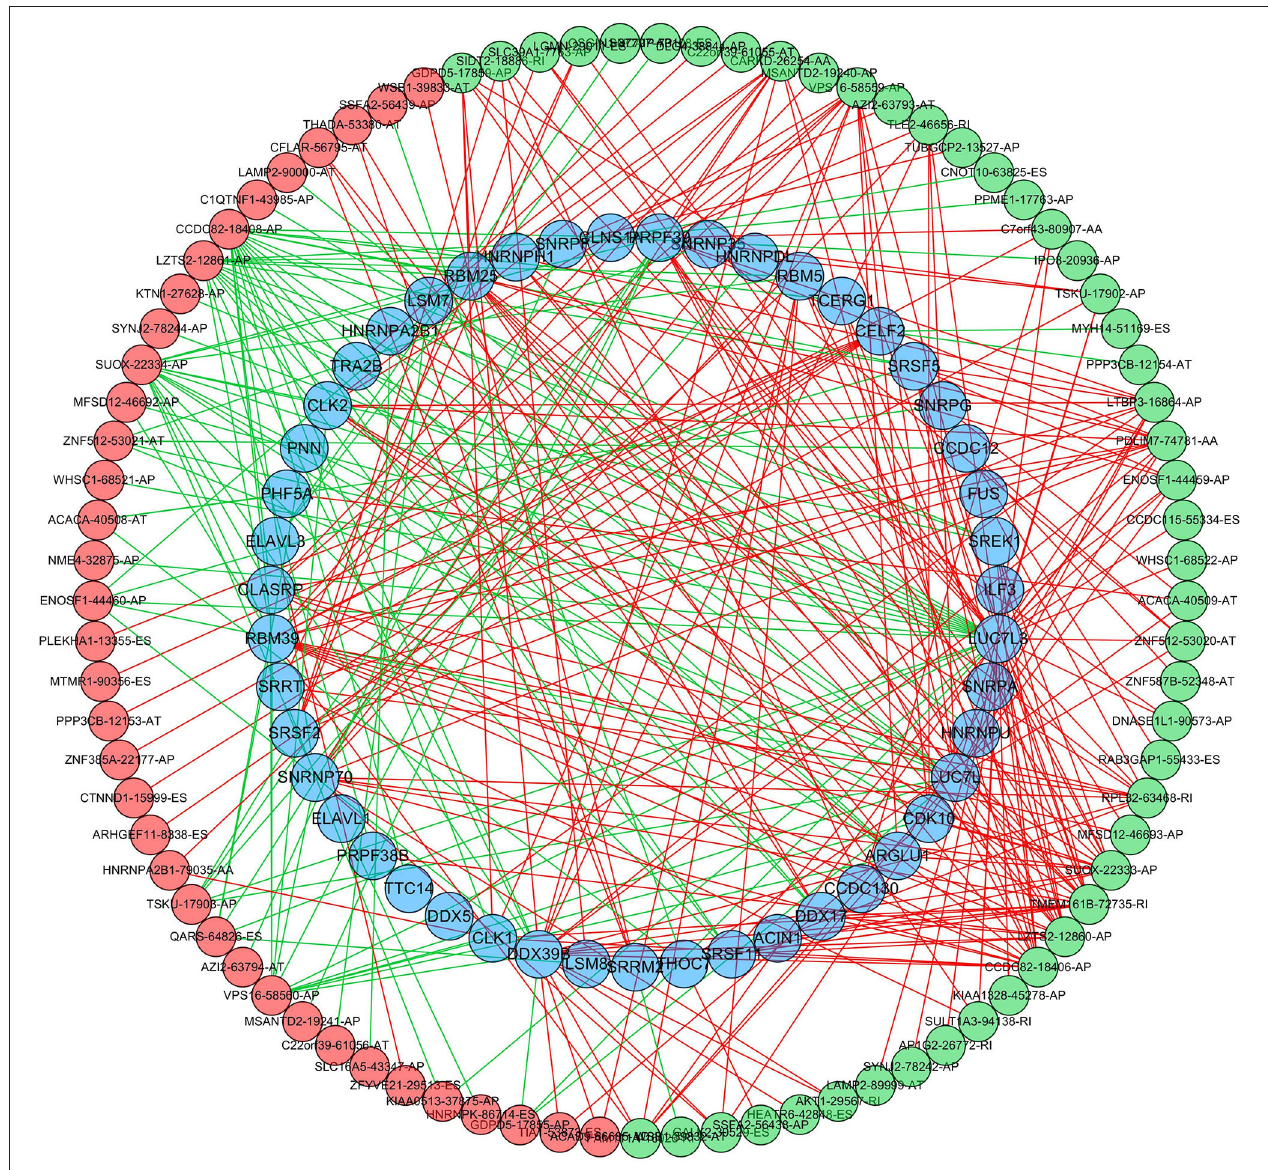
FIGURE 9 | Regulatory network of SFs and survival-related AS events in LUSC. The favorable prognosis AS events (green dots) or adverse prognosis AS events (red dots) were positively (red line) or negatively (green line) regulated by the expression of SFs (blue dots). SFs, splicing factors; AS, alternative splicing.